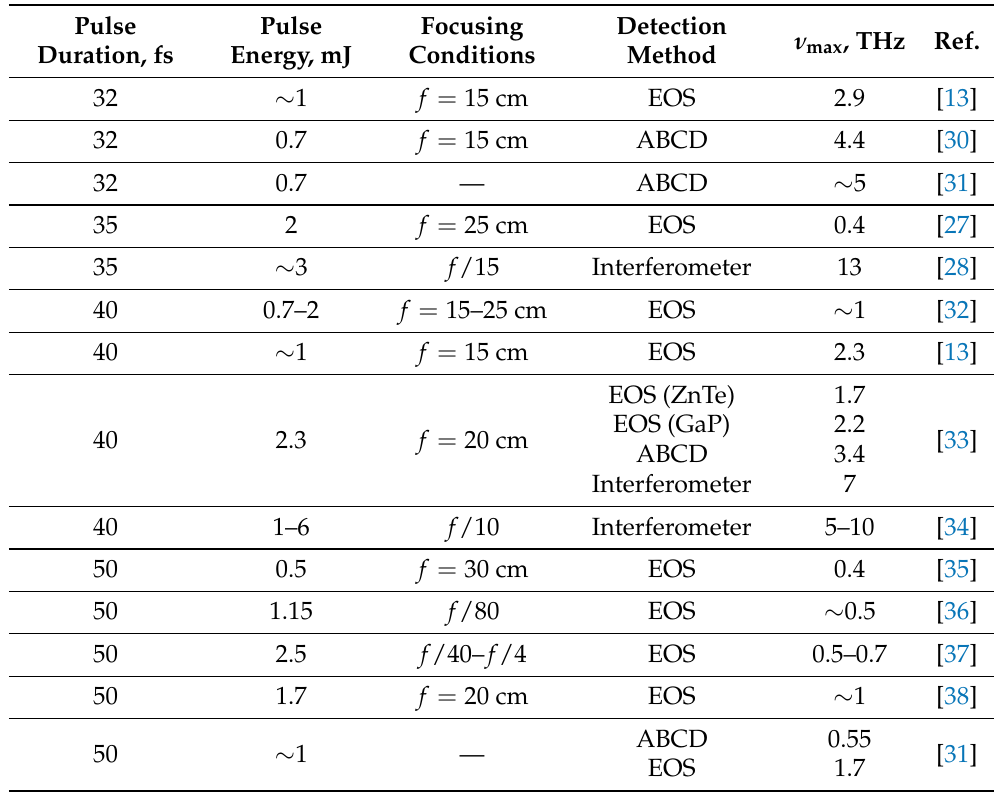
Table 1. The frequency of maximum ν max in the THz spectra measured in different experiments in the conditions close to the ones of our